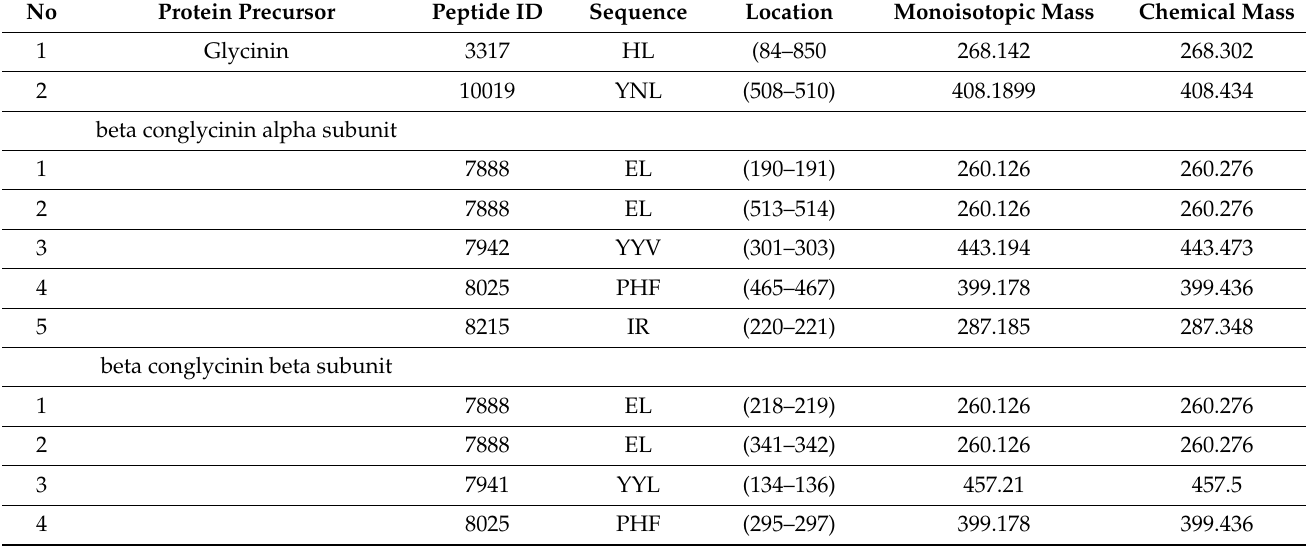
Table 2. In silico assay using papain and bromelain release peptides with antioxidant